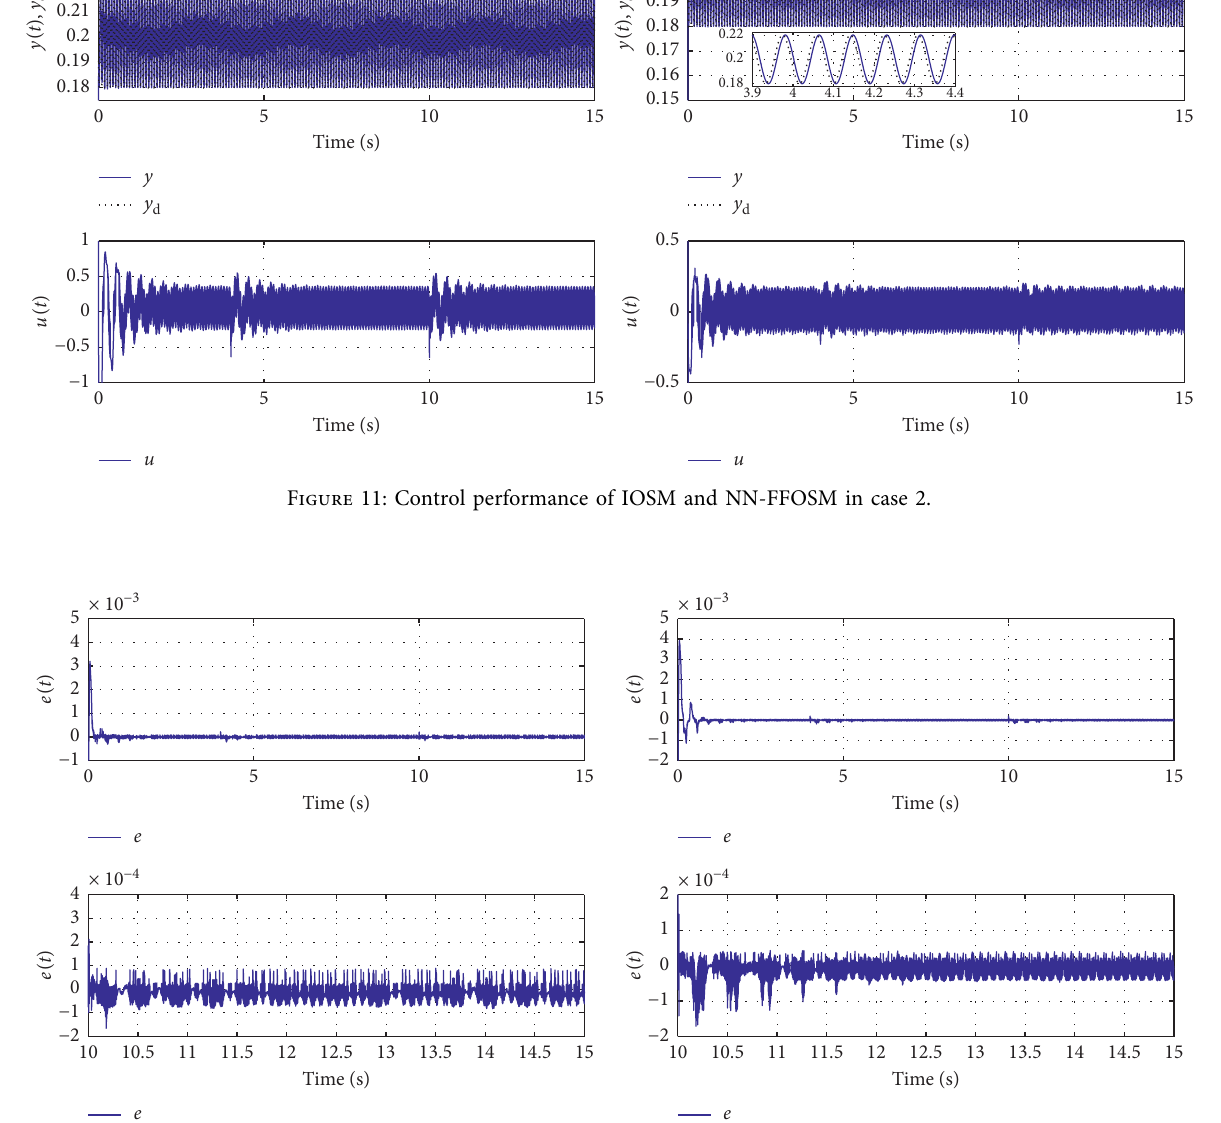
Figure 12: Tracking error of IOSM and NN-FFOSM in case 2.